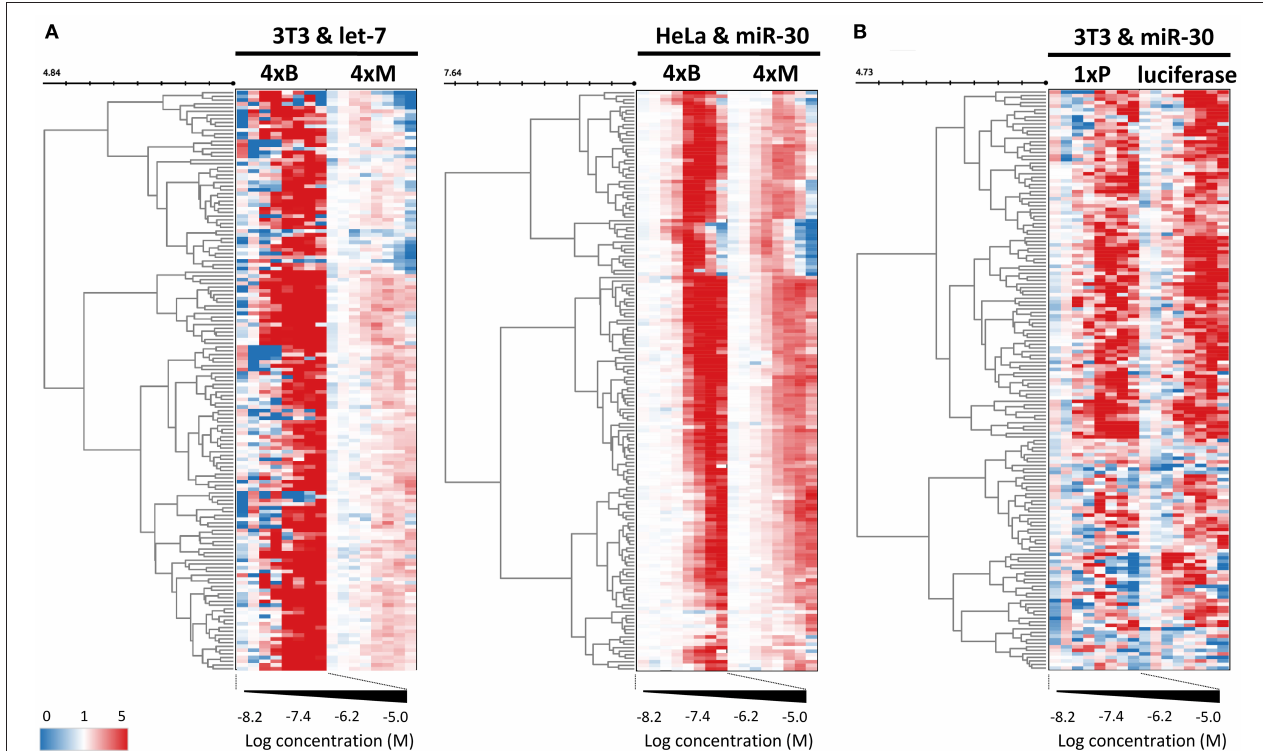
FIGURE 6 | Control reporters reveal high abundance of non-specific (miRNA-independent) hits. (A) Heatmap depicting the concentration-dependent response of miRNA-sensitive and insensitive reporter pairs to 163 putative miRNA inhibitors. These reporters utilized the PGK promoter and BGH 3 ′ UTR. While mutated reporters (4xM) were transiently transfected to HeLa and 3T3 cells, bulged miRNA-sensitive reporters (4xB) were stably integrated. Note that while mutated reporters are generally less upregulated, they yield essentially the same heatmap pattern as the matched reporters with intact miRNA binding sites. The color scale values represent linear relative luciferase activity. (B) Heatmap depicting the concentration-dependent response of miRNA-sensitive (1xP) and insensitive (luciferase) reporters that utilized the SV40 promoter and SV40 3 ′